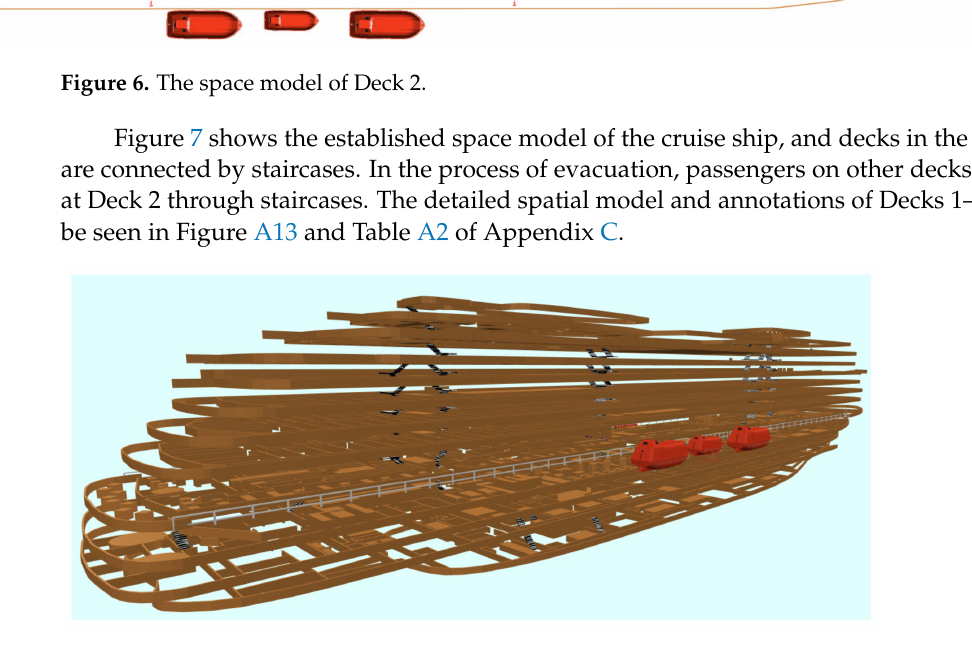
Figure 7. The space model of the cruise